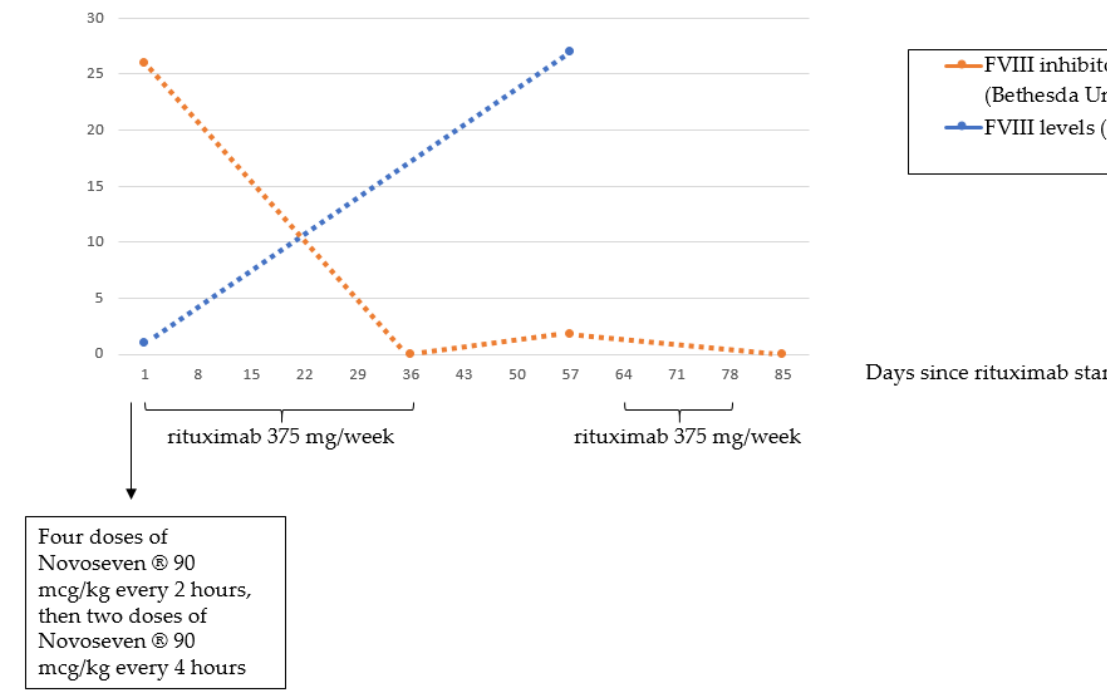
Figure 4. Time-course of FVIII inhibitor titer and FVIII levels in relation with Novoseven ® and rituximab administration.